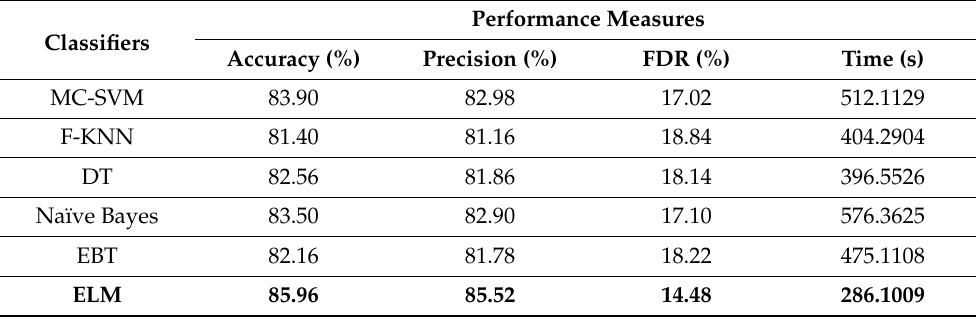
Table 5. Classification accuracy using originally extracted deep features for ISIC2018 dataset.